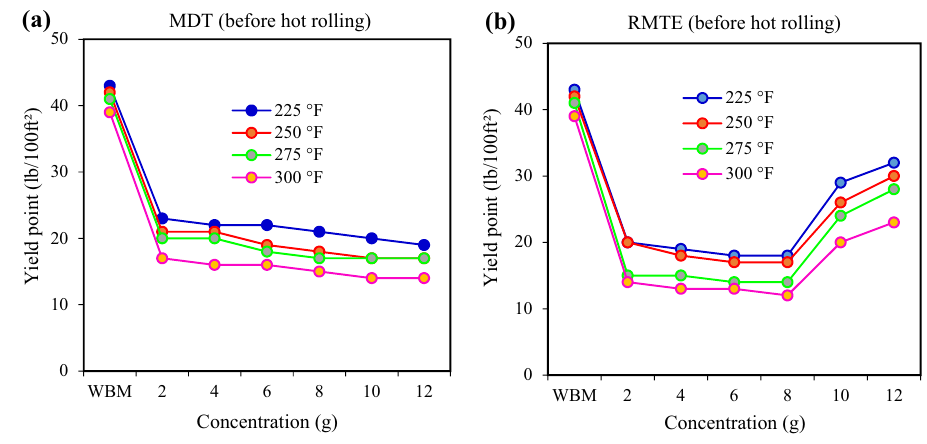
Fig. 7 Yield point of a MDT and b RMTE at different tem-